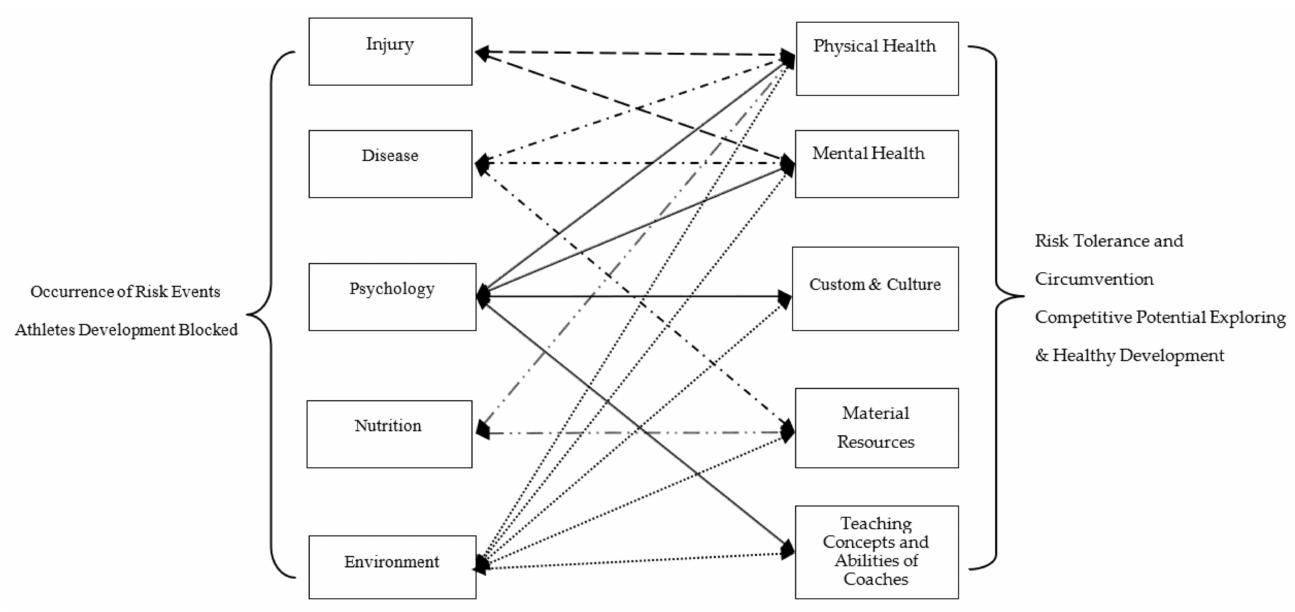
Figure 1. Relationships between risk events and sports training prerequisites of adolescent